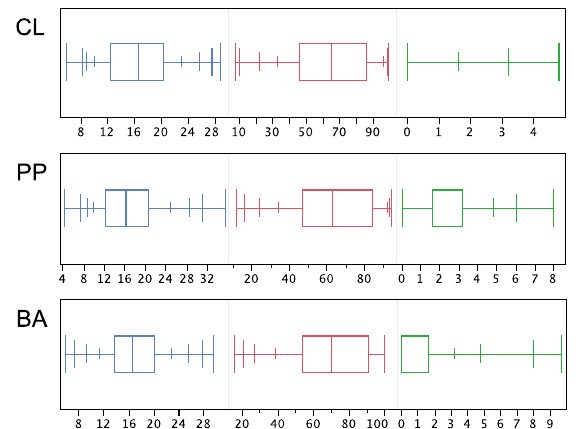
Figure 1. Boxplots of hourly weather observations per forest type, respectively air temperature (°C, left), relative humidity (%, center), and wind speed (km h − 1 , right); The line within the box indicates the median; the top and bottom boundaries of the box denote the 75th and 25th percentiles; the remaining lines correspond to percentiles 0, 0.5, 2.5, 10, 90, 97.5, 99.5, and